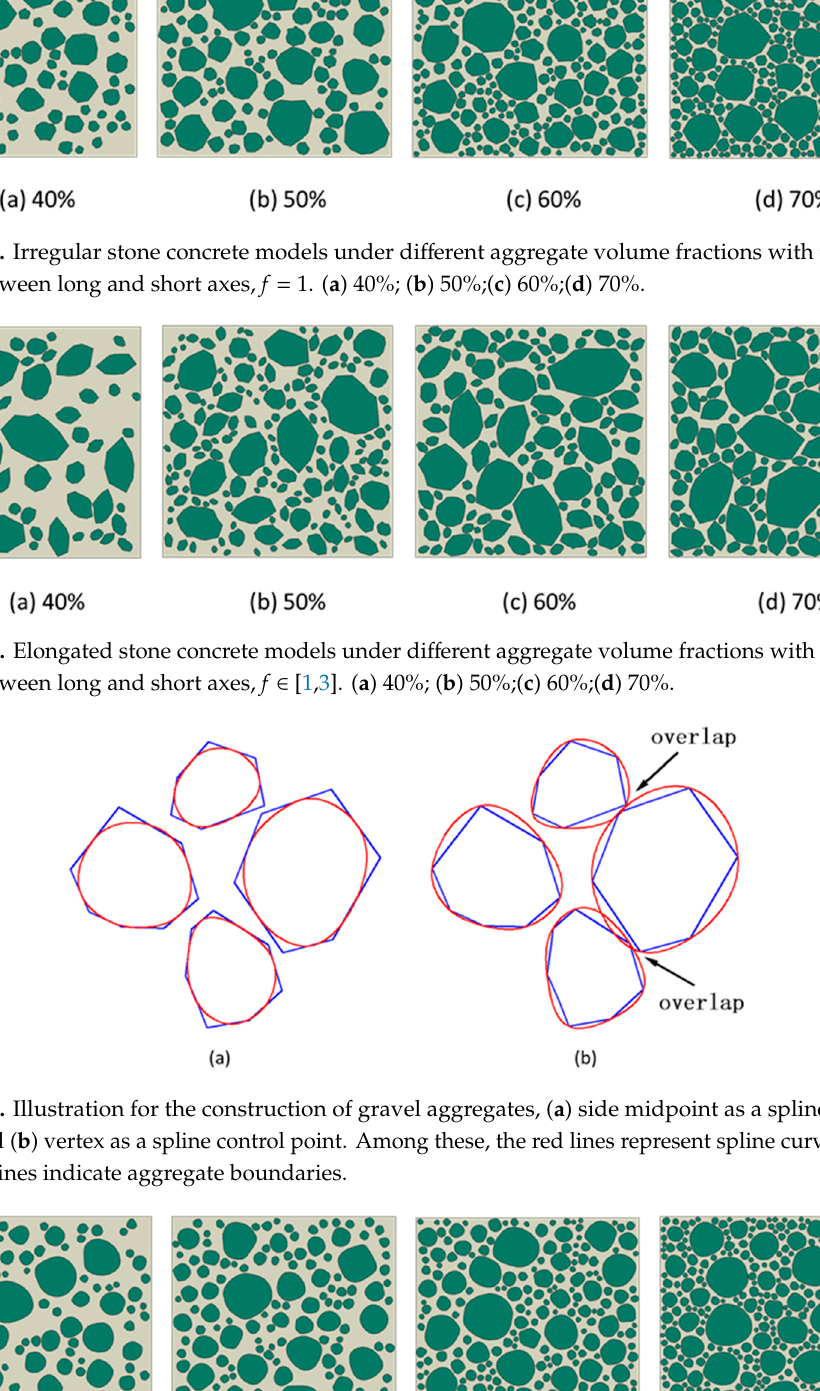
Figure 16. Low-sphericity and well-rounded stone concrete models under different aggregate volume fractions, ( a ) 40%, ( b ) 50%, ( c ) 60%, and ( d ) 70%, respectively, with the scale factor between long and short axes, f ∈ [1,3]. Figure 17. Typical element meshes for the irregular stone and rounded stone concrete models with the aggregate volume fraction 50%. ( a ) Triangle element meshes and ( b ) Quadrilateral element meshes. 4.5. Efficiency of Algorithms in the 2D Dot Matrix Method To test the algorithm efficiency in the present DMM, we examined the time required to generate a numerical concrete model with different aggregate volume fractions using three dot matrices, as illustrated in Figure 18. The work was performed via the desk computer with Intel(R) Core(TM) i7- 4810MQ CPU @ 2.80GHz. We found that as the number of dot matrix increased, the computational time of aggregate placement was enhanced. However, in the 2D case, a current desk computer with the memory of 8 GB was enough to process the laboratory scale model of interest. In general, the values of NumX and NumY satisfy the minimum requirement of Equation (16) to achieve the balance between calculation time and aggregate placement without the excessive pursuit of a larger number of the dot matrix.